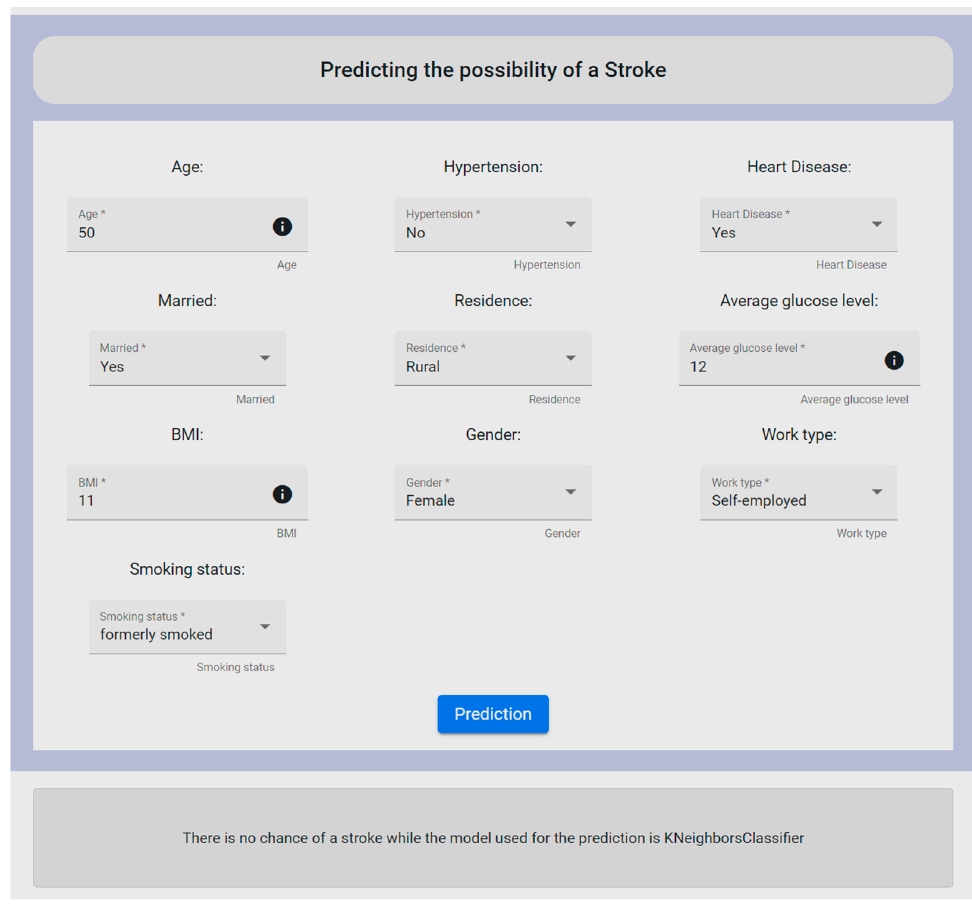
Figure 10. Example of stroke probability form.